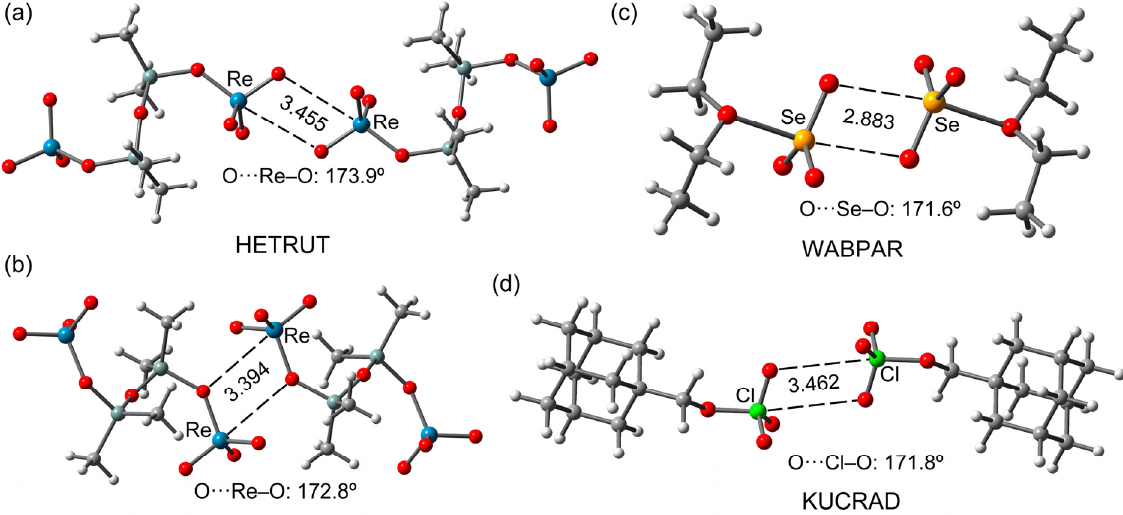
Figure 4. Fully optimized dimers of HETRUT ( a , b ), WABPAR ( c ) and KUCRAD ( d ). Distances in Å.